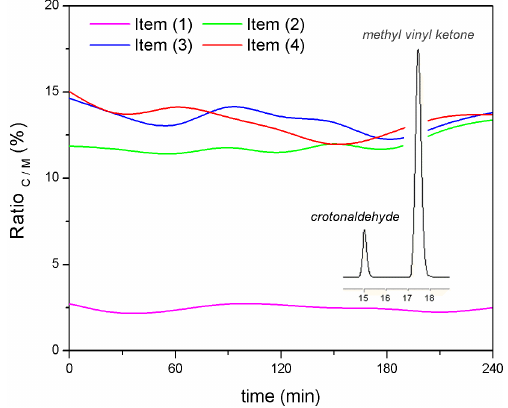
Fig. 1. Transformation of MVK in water solution. Item (1): 0.2mM MVK in acetonitrile (pH = 7); Item (2): 0.2mM MVK in ultrapure water (pH = 7); Item (3): 0.2mM MVK + 2mM H 2 O 2 in ultrapure water (pH = 7); and Item (4): 0.2mM MVK + 2mM H 2 O 2 in ul- trapure water (pH = 4). (The inset figure is the HPLC-UV spectra of MVK dissolved in ultrapure